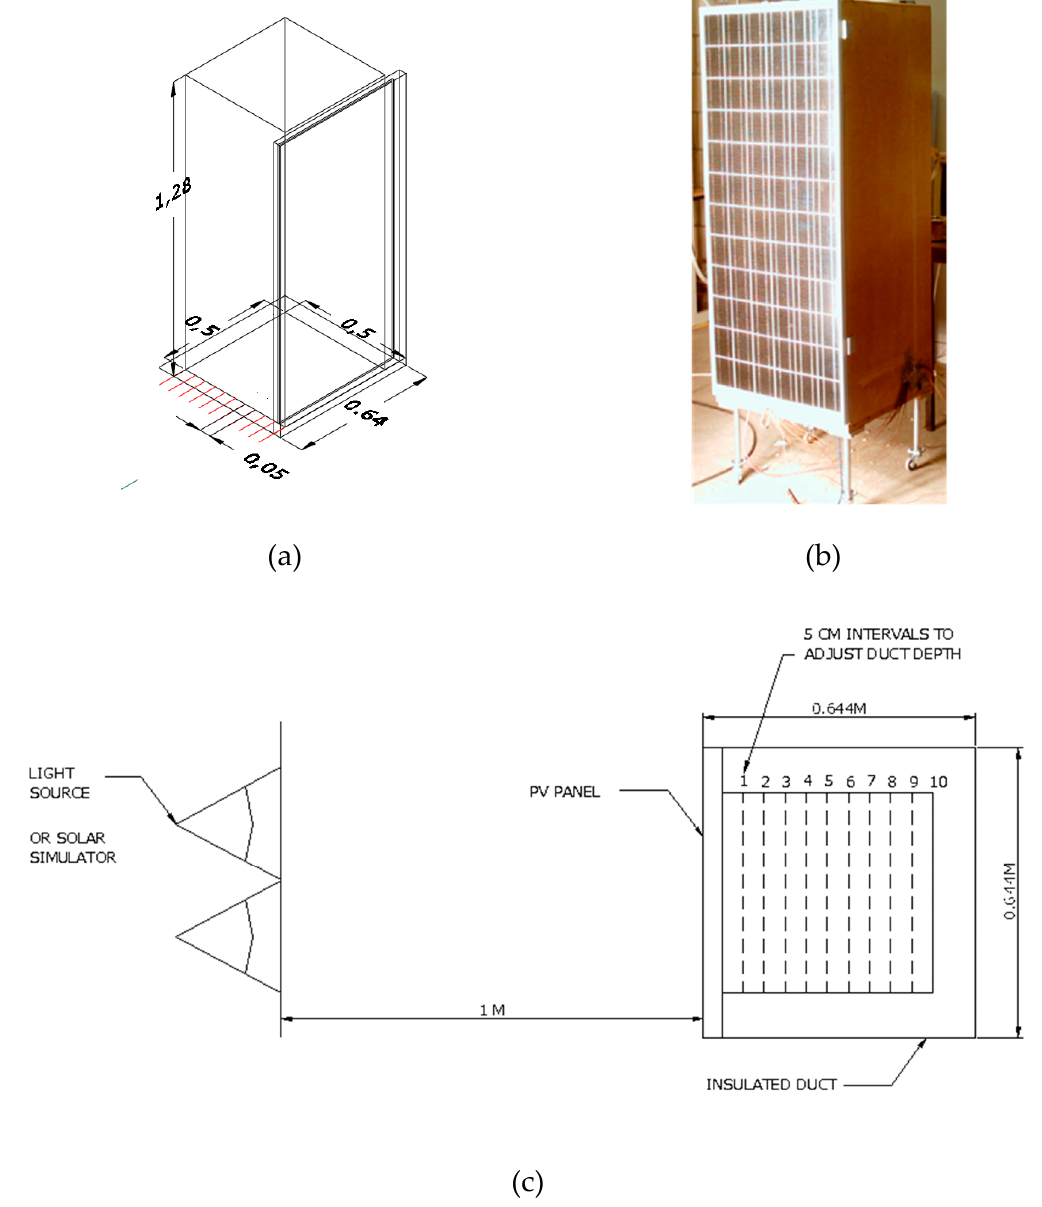
Figure 1. ( a ) Three-dimensional schematic of the practical experiment; ( b ) a photo of the experimental setup; ( c ) a schematic plan of the experimental setting and sequence of duct positions.